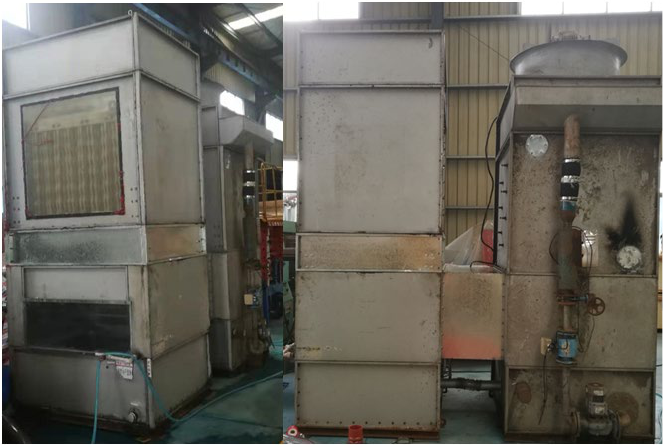
Figure 3. Schematic diagram of the vertical CECT after renovation.